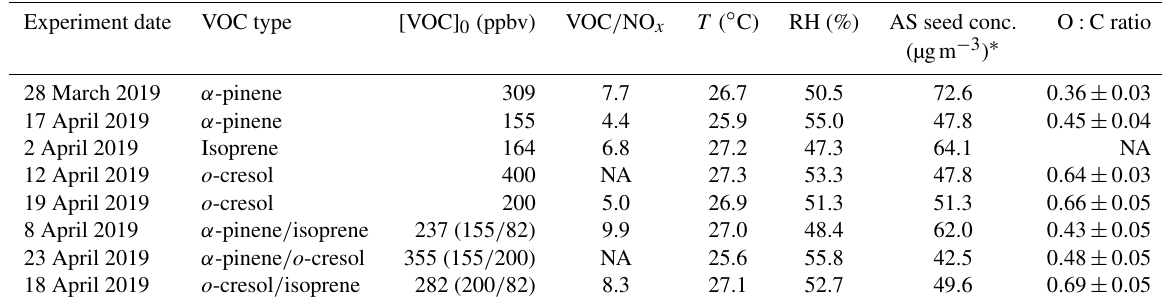
Table 1. Summary of the initial conditions of chamber experiments. Experiment